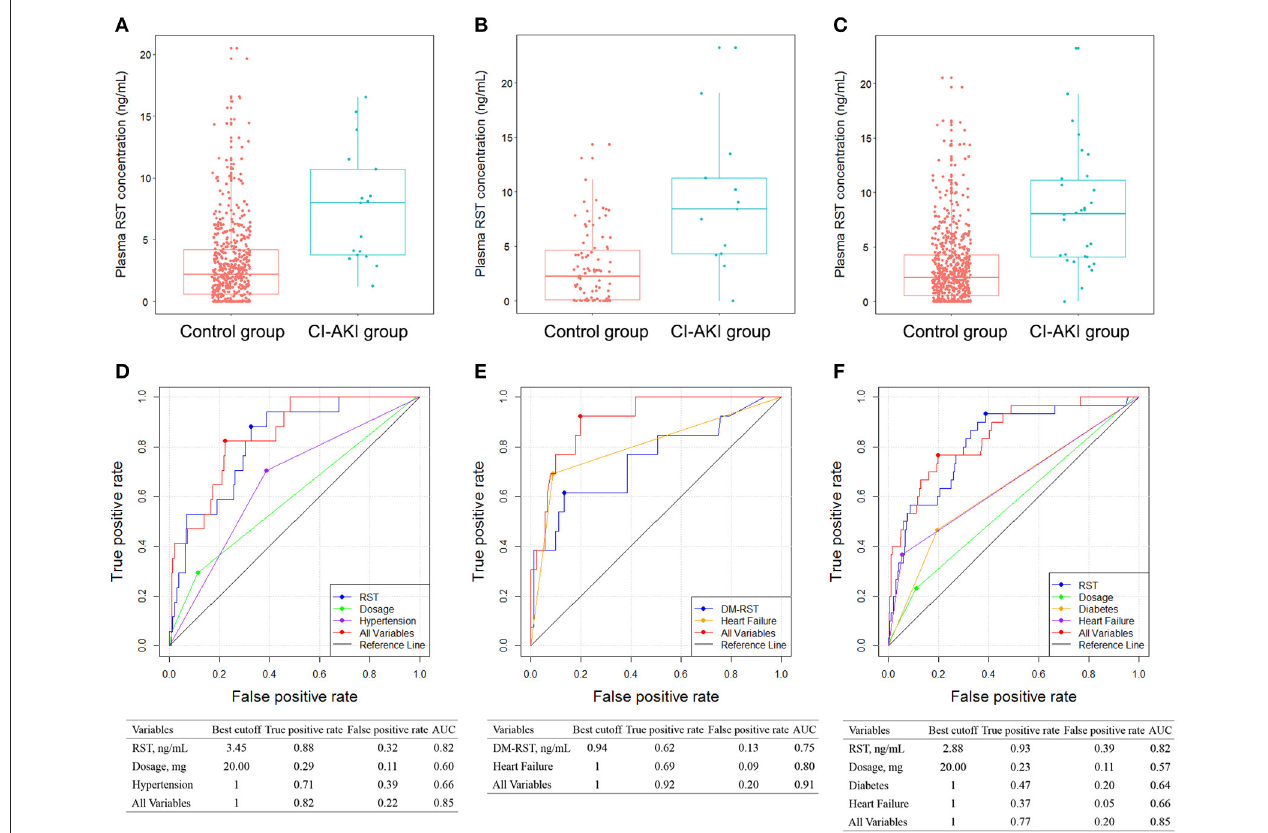
FIGURE 3 | Comparison of plasma RST concentration between control group and CI-AKI group in patients without CKD (A) , in patients with CKD (B) , and in all patients (C) in stage II. ROC analyses of variables for predicting CI-AKI in patients without CKD (D) , in patients with CKD (E) , and in all patients (F) in stage II. DM-RST: N-desmethyl rosuvastatin, RST: rosuvastatin; other abbreviations as in Figures 1 , 2